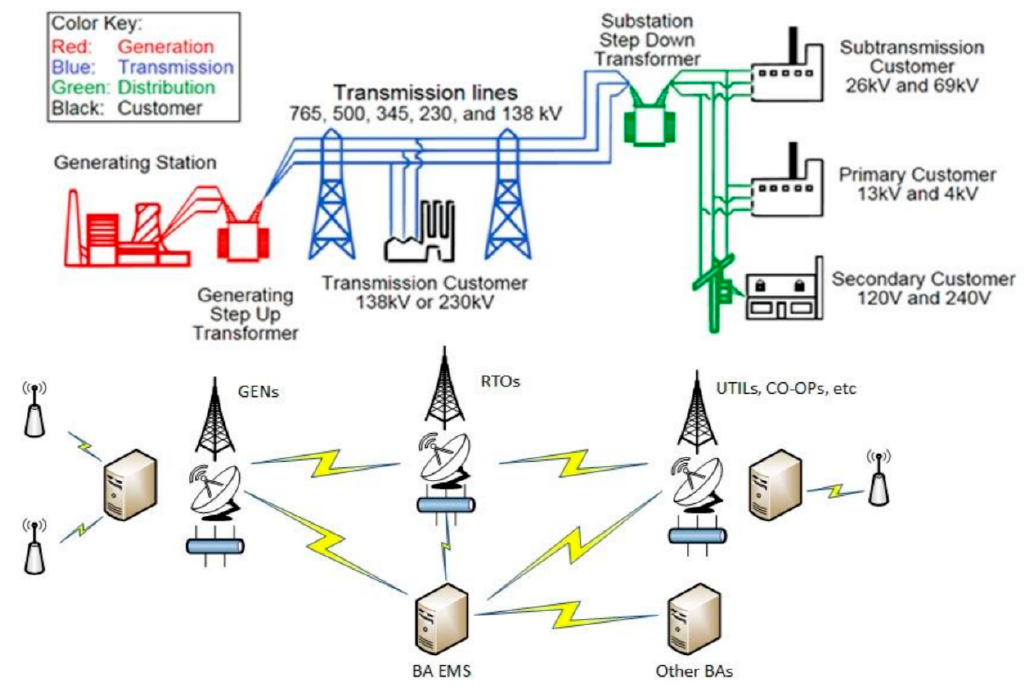
Figure 1. Typical structure of an electric power system (source: INL, 2016). 54